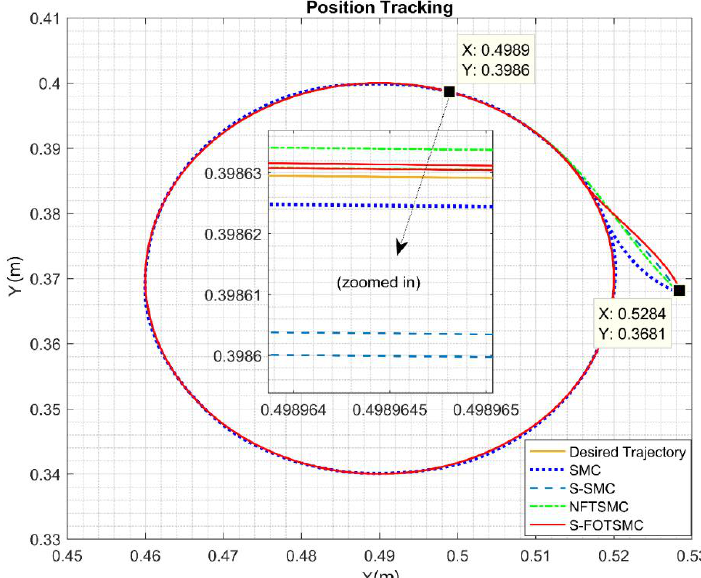
Figure 3. The desired trajectory and real trajectory of the end-effector when the parallel manipulator tracks a circular trajectory.